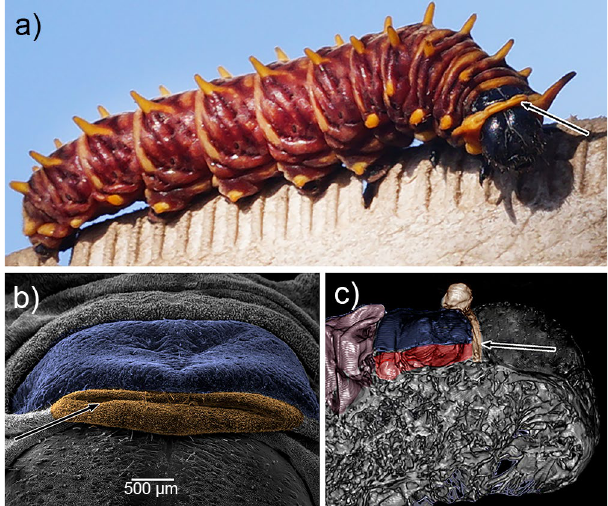
Figure 2. Osmeterium location in Battus polydamas archidamas when it is retracted. ( a ) alive larva; ( b ) prothorax view under scanning electron microscope; note the prothorax represented in blue and the osmeterium in orange; ( c ) prothorax and head of larvae under micro-CT; note the prothorax represented in blue and the space where most part of the osmeterium is saved in